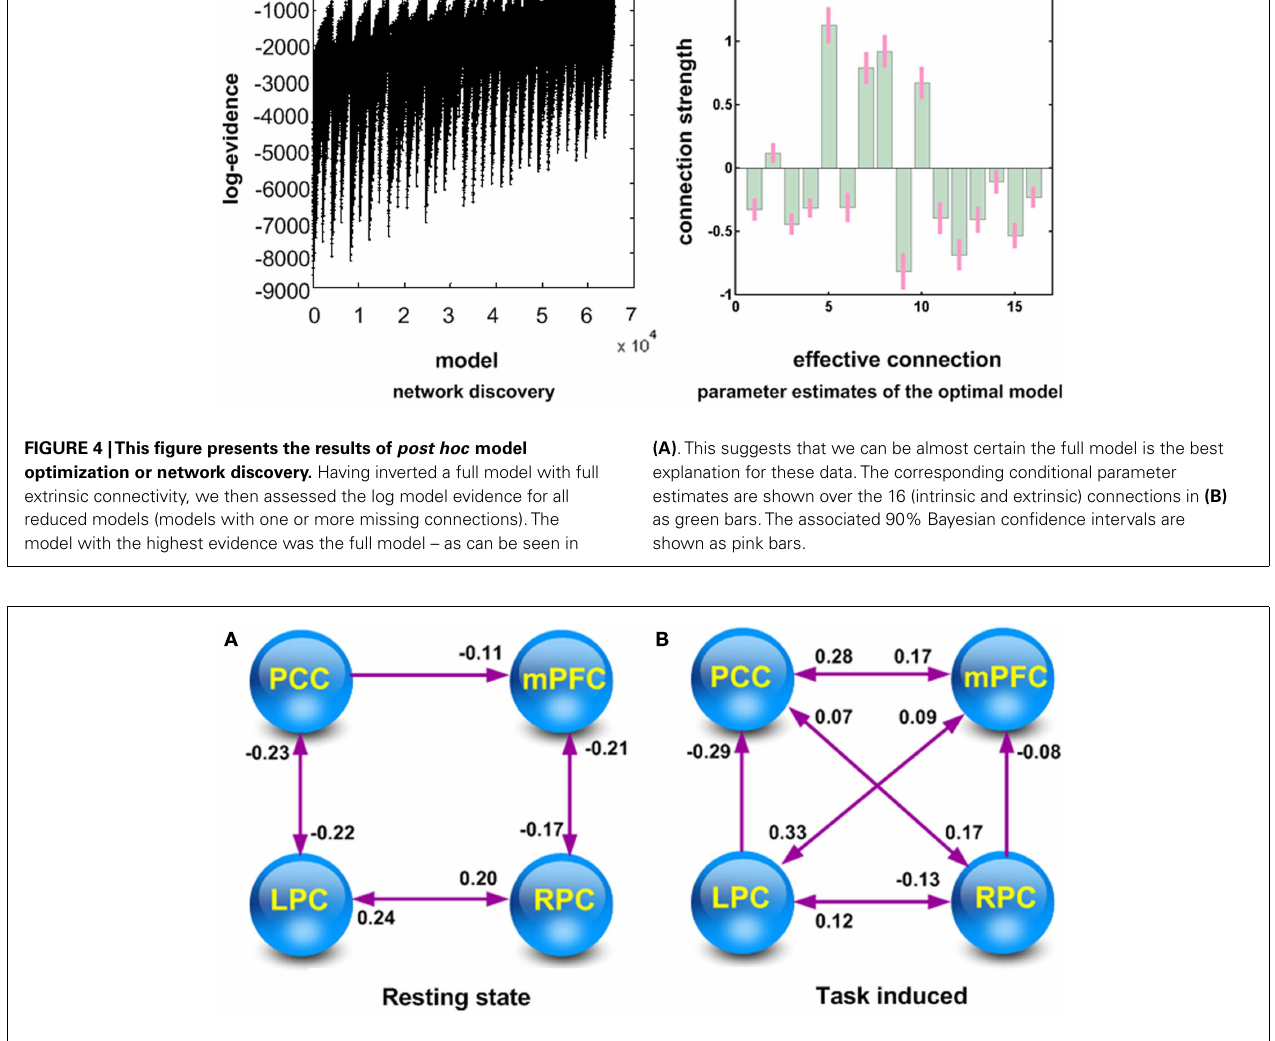
FIGURE 5 | Significant connections within the average full model under rest (A) and task (B) sessions. Only the connections greater than zero, with more than 95% confidence are shown.The posterior